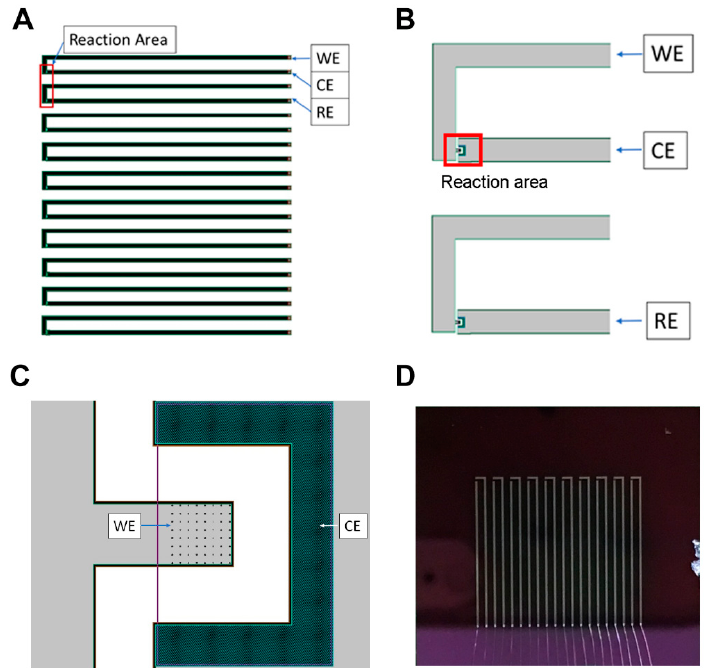
Figure 1. The complementary metal oxide semiconductor (CMOS) sensing chip with titanium nitride three-dimensional nano-electrodes (TiN 3D-NEA). ( A ) The sensing chip contains 10 units of working (WE) and counter electrodes (CE). ( B ) The enlarged reaction area of the electrode set in (A). The counter electrode of the adjacent electrode unit was used as the reference electrode (RE). ( C ) The diagram of an electrochemical sensing unit on the CMOS chip. Each sensing unit contained an 8 × 8 nano-electrode array as a WE and a CE. ( D ) The fabricated CMOS sensing chip (20 mm × 20 mm) with bonding wires (bottom part).